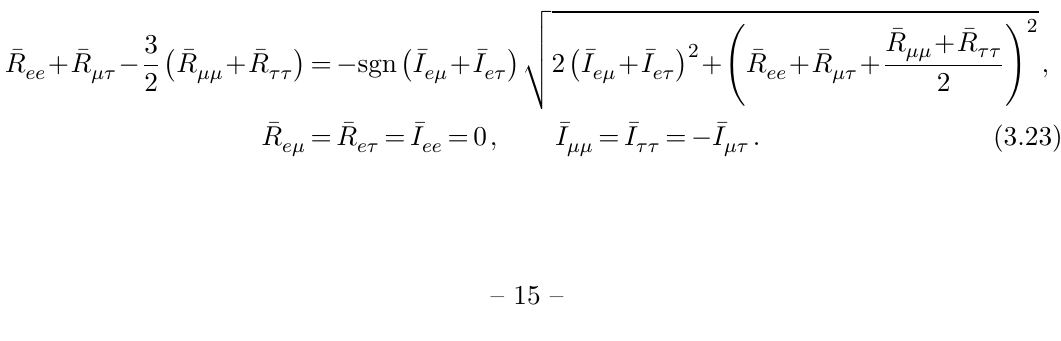
Figure 6 . jh m i j as a function of the lightest neutrino mass ( m ee case) for the possible combinations [ (cid:26); (cid:27) ] = [0 ; 0] ; [0 ; (cid:25)= 2] ; [ (cid:25)= 2 ; 0] and [ (cid:25)= 2 ; (cid:25)= 2] in the case of two sides of equations A, C, F and G being